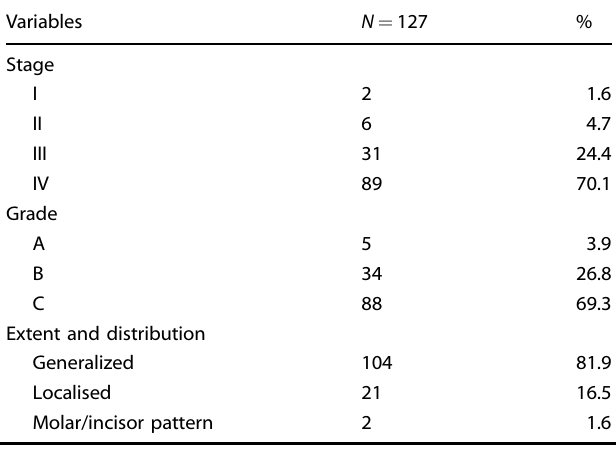
Table 6. Distribution of periodontitis according to the stage, grade and